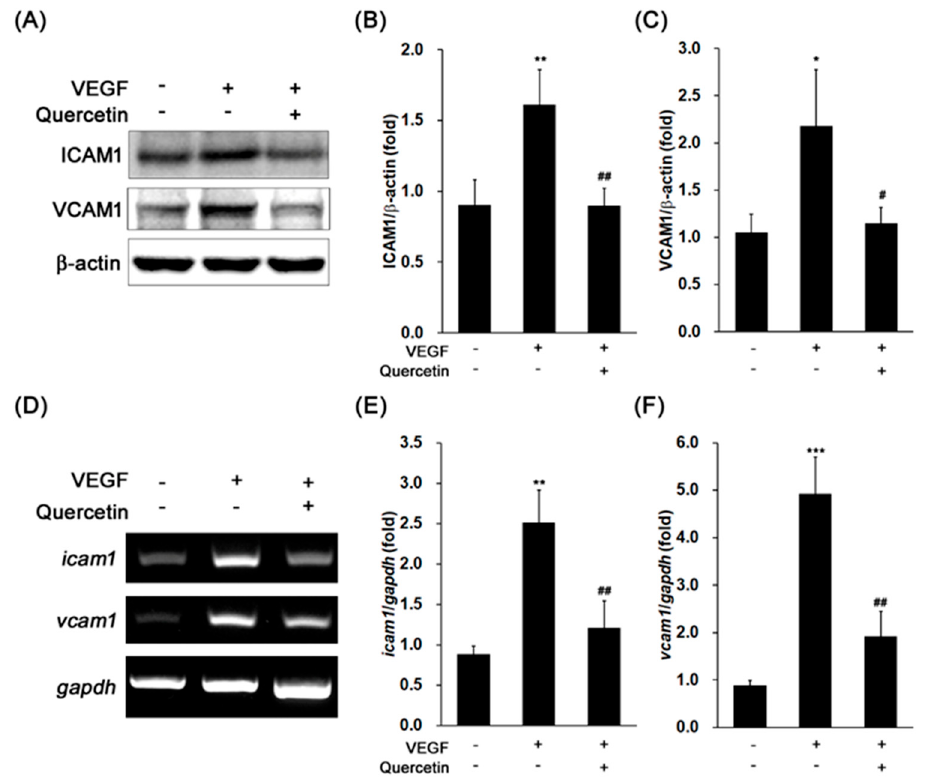
Figure 3. Effect of quercetin on the expression of ICAM1 and VCAM1 in VEGF-stimulated 661W cells. ( A ) Cells were treated with VEGF (20 ng/mL) in the absence or presence of quercetin (0.1 µM) for 16 h. The protein expression was detected by immunoblot. ( B , C ) Densitometry quantifications of ICAM1 ( B ) and VCAM1 ( C ) protein expression were measured by ImageJ. Data are the means ± SDs of three independent experiments. * p < 0.05 and ** p < 0.01 indicate significant differences compared to the non-treated control group. # p < 0.05 and ## p < 0.01 indicate significant differences compared to the VEGF-only treated group. ( D ) Cells were treated with VEGF (20 ng/mL) in the absence or presence of quercetin (0.1 µM) for 6 h. Gene expression was determined by RT-PCR. ( E , F ) Densitometry quantifications of icam1 ( E ) and vcam1 ( F ) gene expression were measured by ImageJ. Data are the means ± SDs of three independent experiments. ** p < 0.01 and *** p < 0.001 indicate significant differences compared to the non-treated control group. ## p < 0.01 indicates significant difference compared to the VEGF-only treated group.